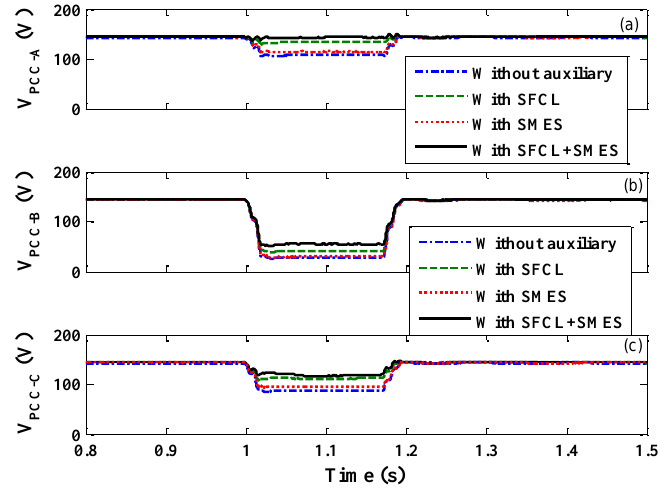
Figure 18. Simulation results of the PCC voltage (root-mean-square (RMS) value) under the asymmetrical fault. ( a ) A-phase voltage; ( b ) B-phase voltage; and ( c ) C-phase voltage.